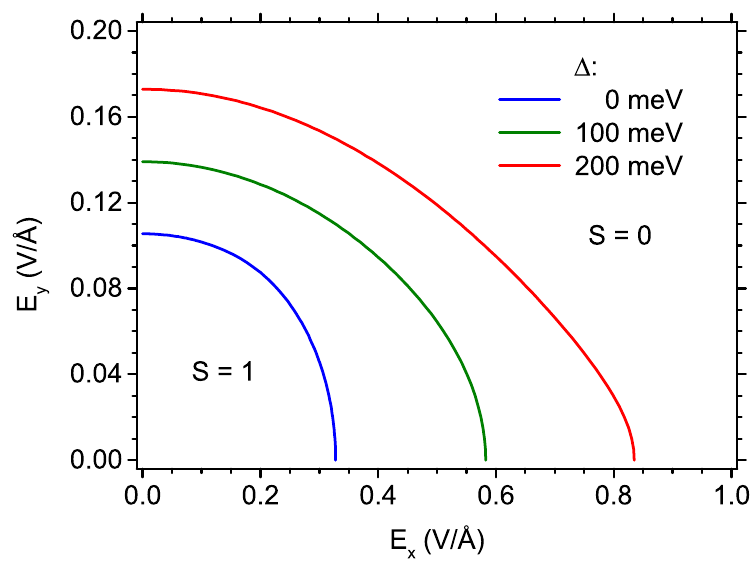
Figure 3. The phase diagram showing the borders between the state with S = 1 and the state with S = 0 as a function of the electric field along the x -direction and along the y -direction, for three values of exchange energy.